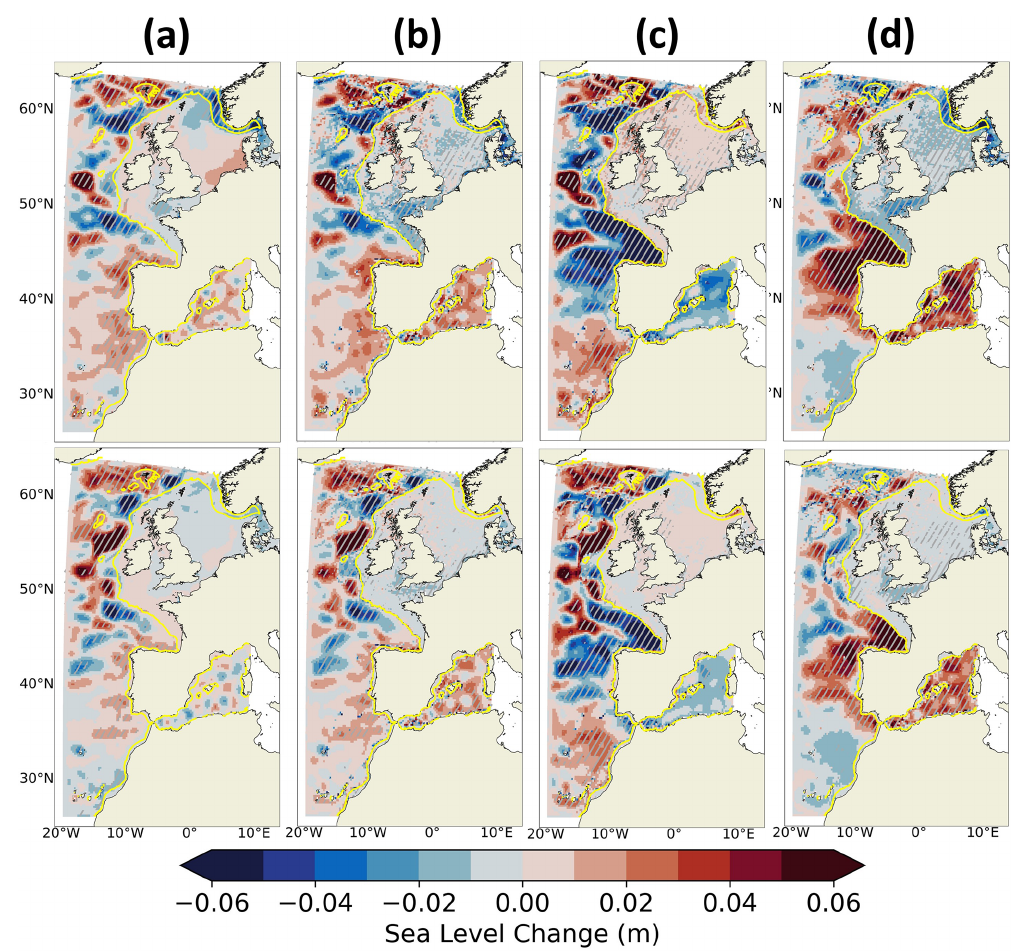
Figure 14. Differences of projected changes (2081–2100 vs. 1986–2005) under the SSP5-8.5 (upper row) and SSP1-2.6 (lower row) sce- narios between CNRM-CM6-1-HR and IBI-CCS_raw for the (a) DSL without IB effect, (b) steric, (c) thermosteric and (d) halosteric SL components. The steric, thermosteric and halosteric SL components have been computed between 0–2000m depth. The differences have been computed on the GCM grid. A Student t test has been performed with a confidence interval of 95%, and the significant differences between the two simulations have been marked with white dots. The shelf break (defined by the 200m isobath) is indicated in